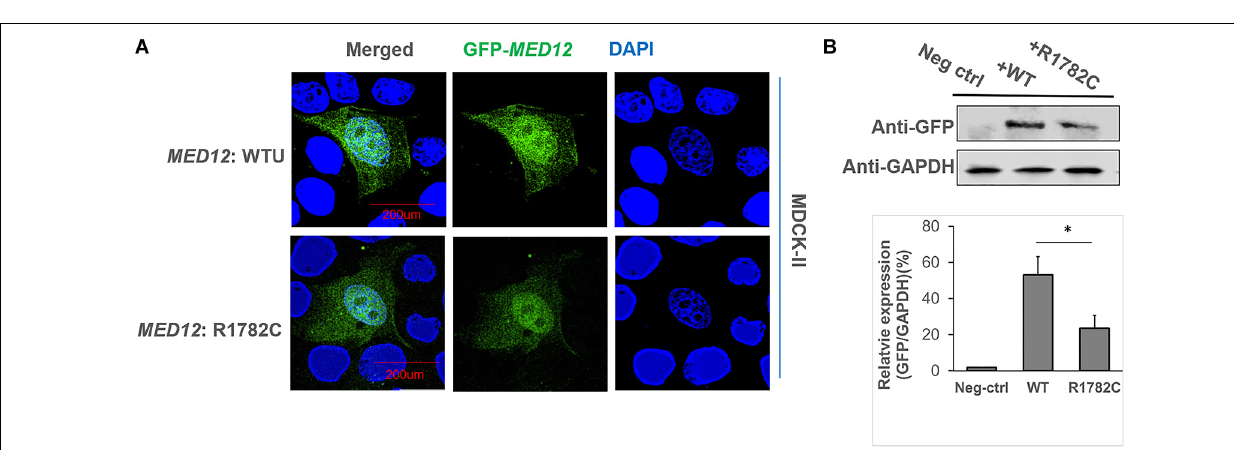
FIGURE 3 | The influence of MED12 p.Arg1782Cys on MED12 subcellular location and protein levels. (A) The subcellular localization of wildtype of MED12 and mutated MED12. MDCK-II cells were transfected with GFP- MED12 (WT and mutants) for 48-h incubation and then were imaged under a deconvolution microscope. WTU: wildtype. The staining assay was performed twice. (B) The variant affected the protein level of MED12. HEK293T cells were transfected with GFP- MED12 (WT and mutants) for 48 h, and then western blotting assays were performed to determine the protein levels. The predicted sizes of WT and mutant constructs are 260 KD. The western blotting assay was repeated three times, and t -tests on the relative protein levels to GAPDH were conducted to assess potential differences between WT and the mutant group. * p < 0.05. Ns: not significant. Three replicates of the transfections and western blotting assays were